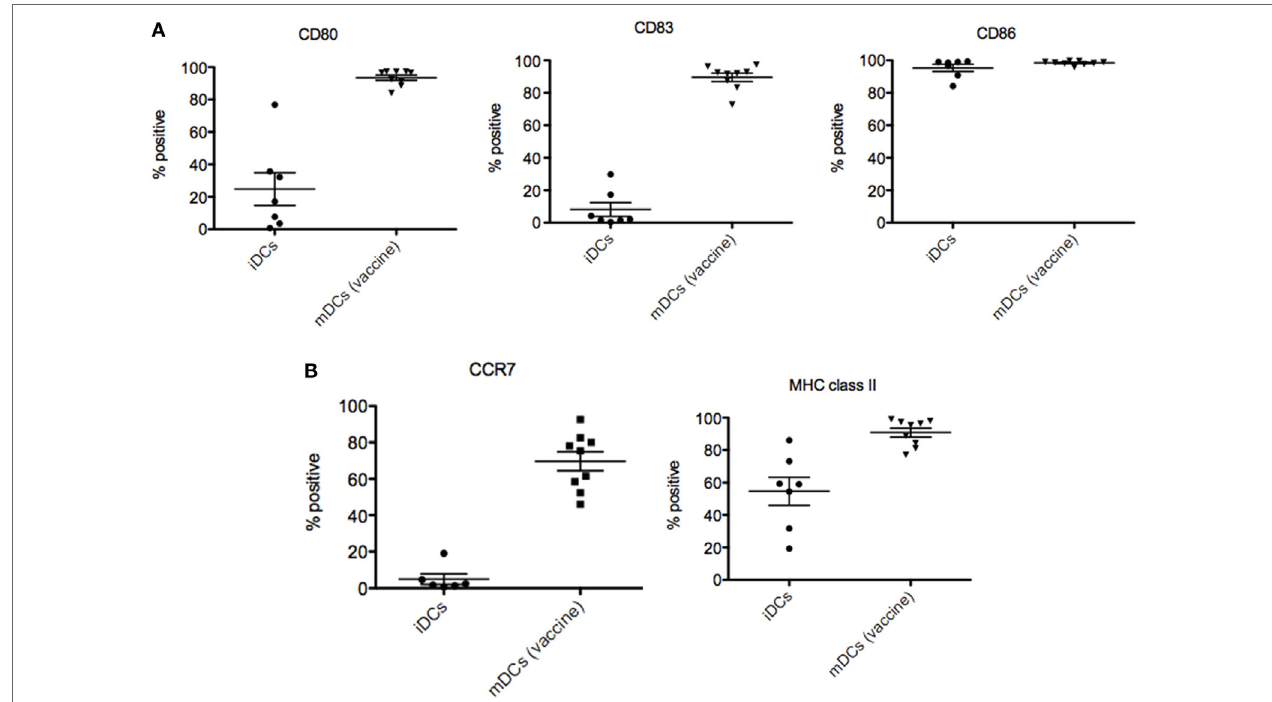
FiGUrE 3 | Characterization of dendritic cells (DCs) vaccines. (a) Increased expression of CD80, CD83, MHC class II, and CCR7 molecules on DCs surface membrane of autologous dendritic cell (ADC) compared to immature DC used as negative control. (B) Increased intensity of molecules (MFI) of ADC after stimulation compared to immature DC used as negative control.